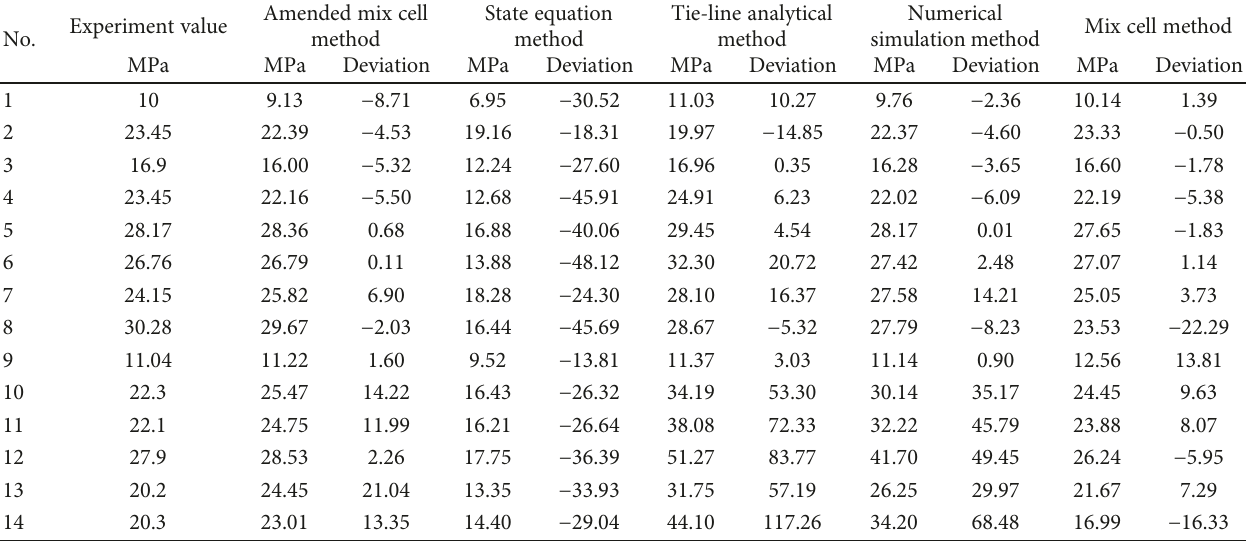
Table 7: MMP calculation deviation